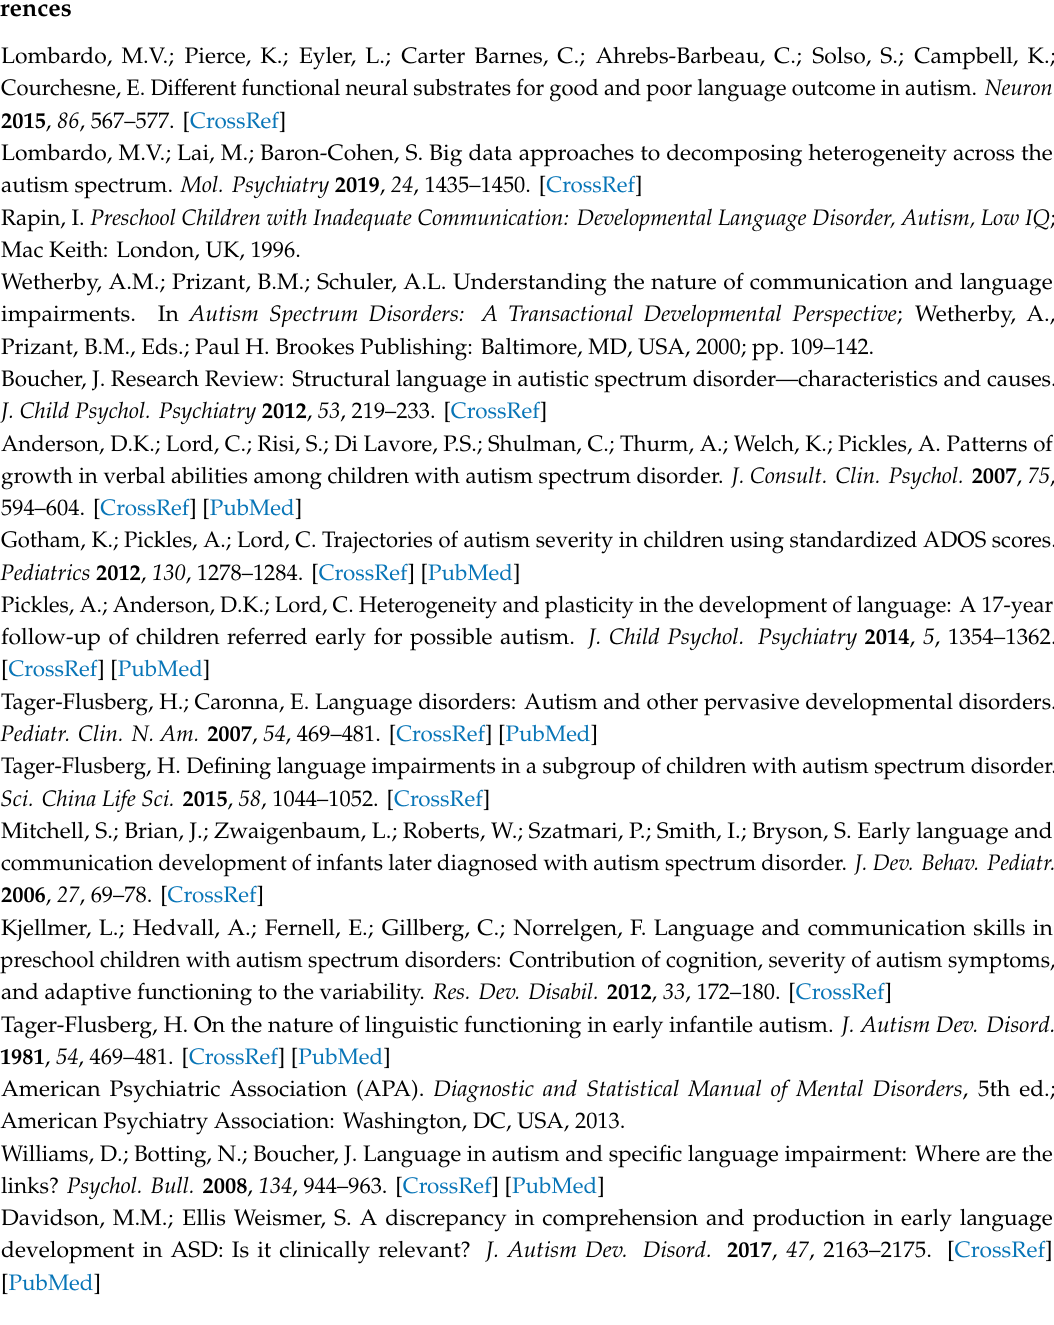
Table S1: The Test of grammatical Comprehension for Children TCGB, [33], Table S2: Grid of Analysis of Spontaneous Speech